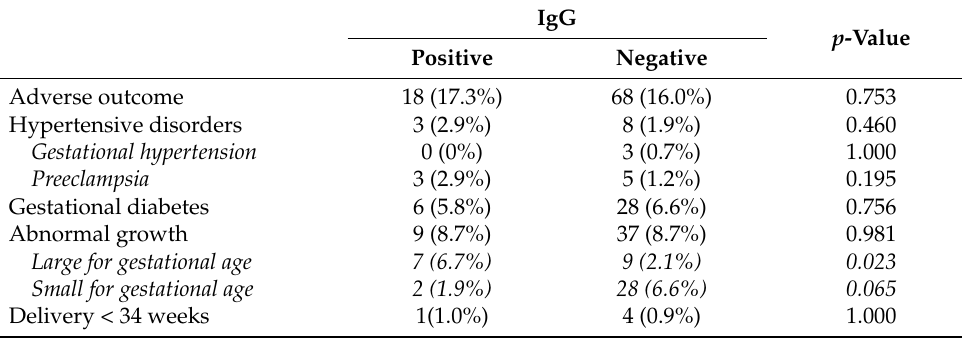
Table 5. Adverse outcomes in women with any positivity to IgG at T0 or